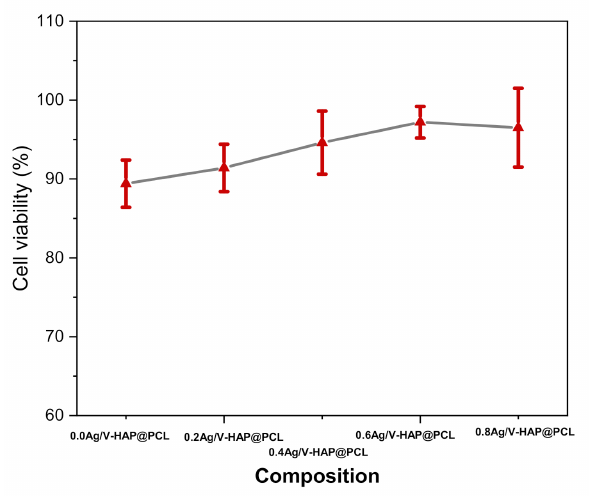
Figure 12. Cell viability of scaffolds of PCL embedded with Ag/V-HAP through human fibroblast cell lines at different Ag